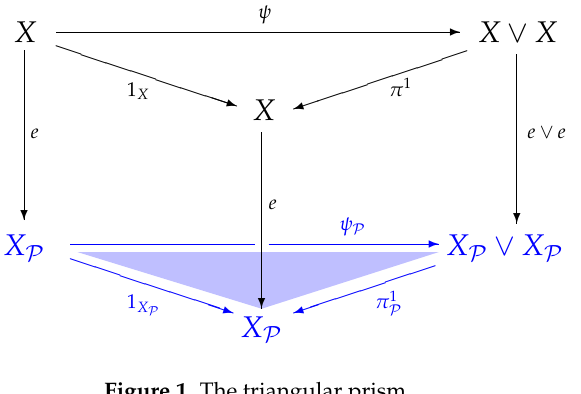
Figure 1. The triangular